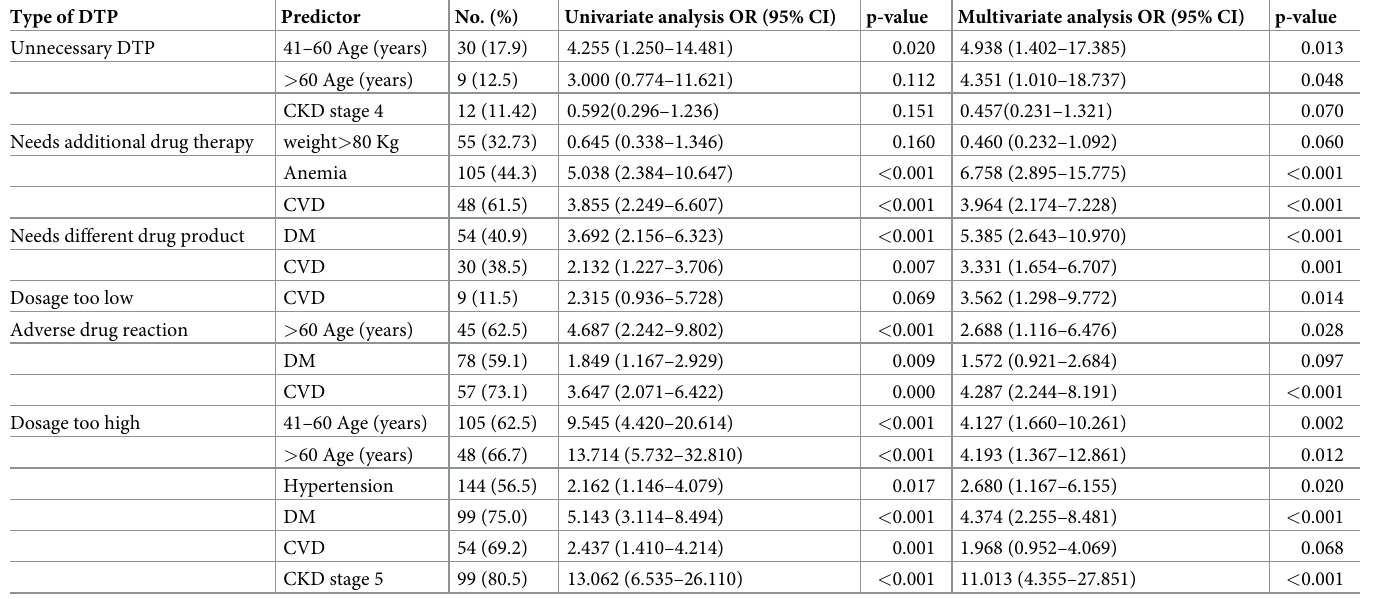
Table 5. Predictors of various types of DTP.